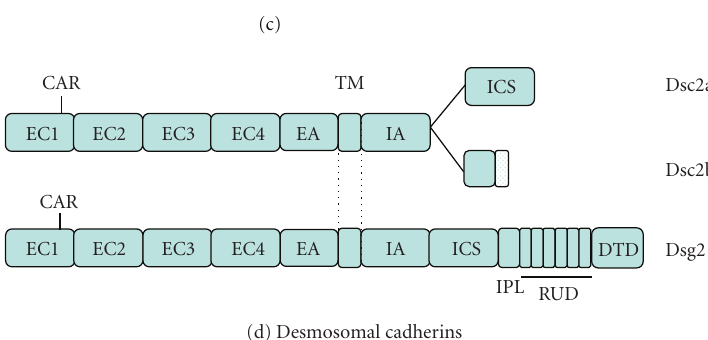
expressed in MDCK cells and the cells assessed at an early stage of confluent culture for increased